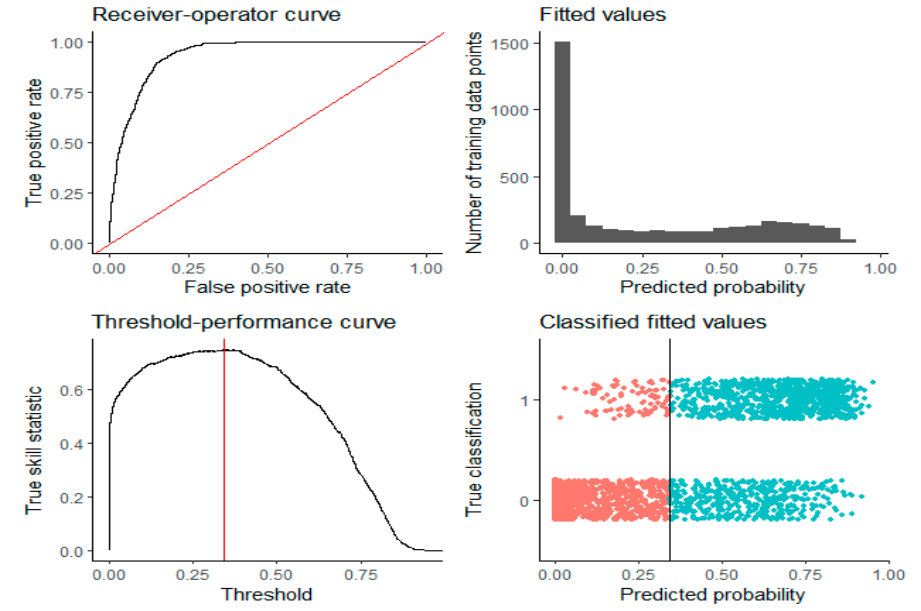
Figure 3. Performance evaluation curves based on the BART model.